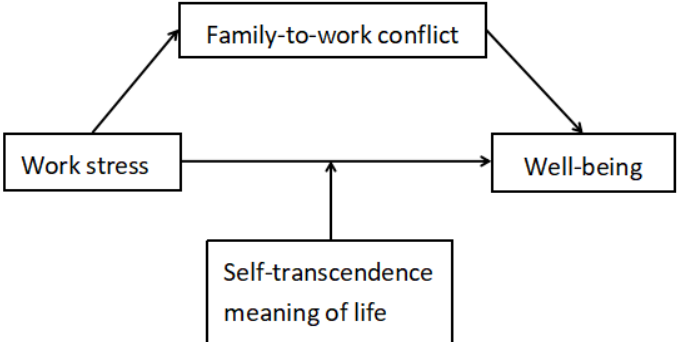
Figure 1. Hypothesis model.